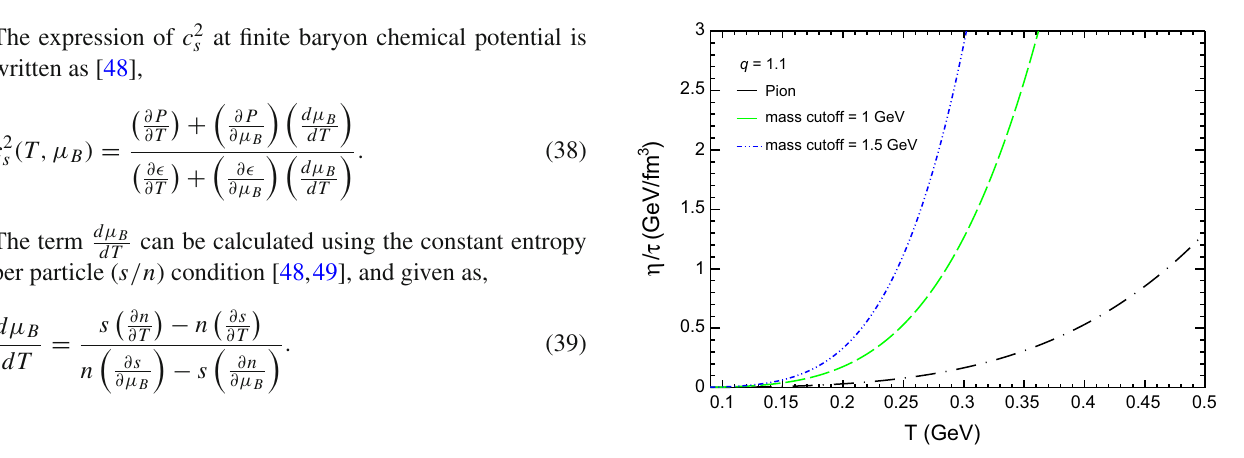
Fig. 1 η/τ versus temperature for various mass cutoff at zero baryon chemical potential